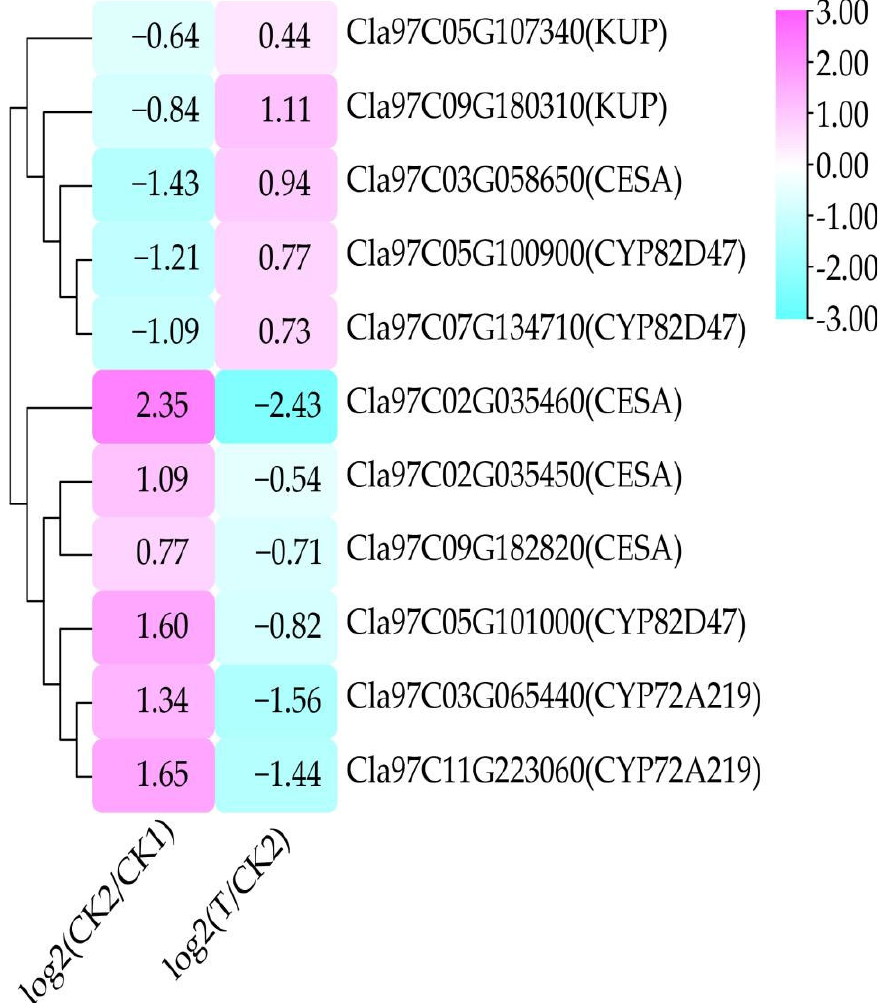
Figure 8. Analysis of DEGs responding to trehalose treatment under salt stress. The color scale ranges from − 3 to 3, with cyan indicating down-regulated and pink indicating up-regulated (see the color set scale). CK1 represents watermelon seedlings cultured in normal Hoagland solution; CK2 represents watermelon seedlings cultured in Hoagland solution containing 150 mM NaCl, and T represents watermelon seedlings cultured in Hoagland solution containing 150 mM NaCl and 20 mM trehalose.